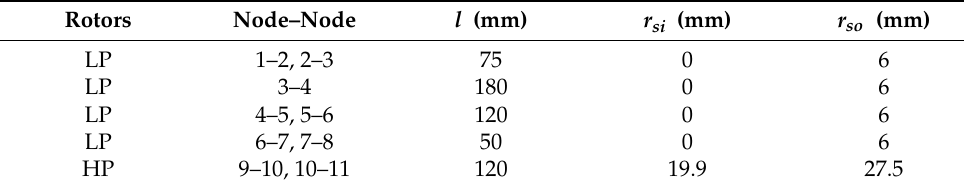
Figure 3. The finite element model for the dual-rotor-bearing system: 1~11 are the serial numbers of nodes, ① ~ ⑤ are the serial numbers of bearings. Table 1. Shaft parameters for the dual-rotor-bearing system.